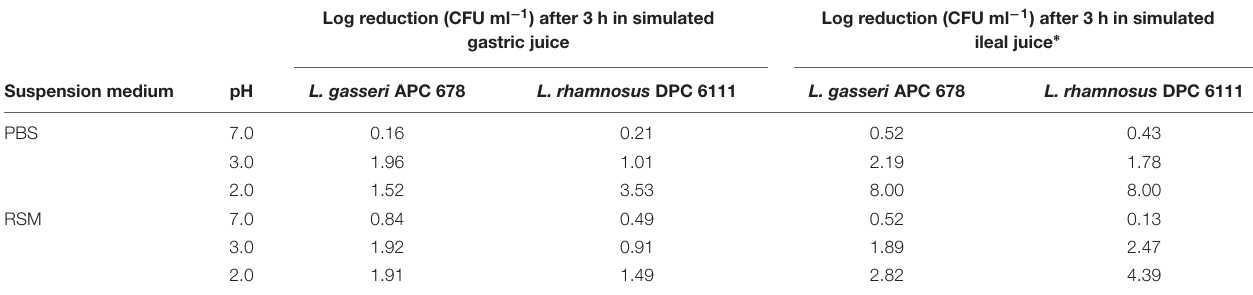
TABLE 2 | Survival of lactobacilli during simulated gastrointestinal tract transit.